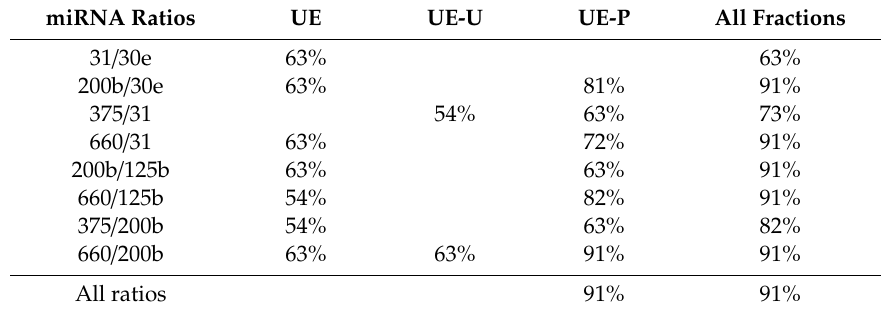
Table 10. Definitely healthy. The percentage of HD divided from the control group (PCa and BPH